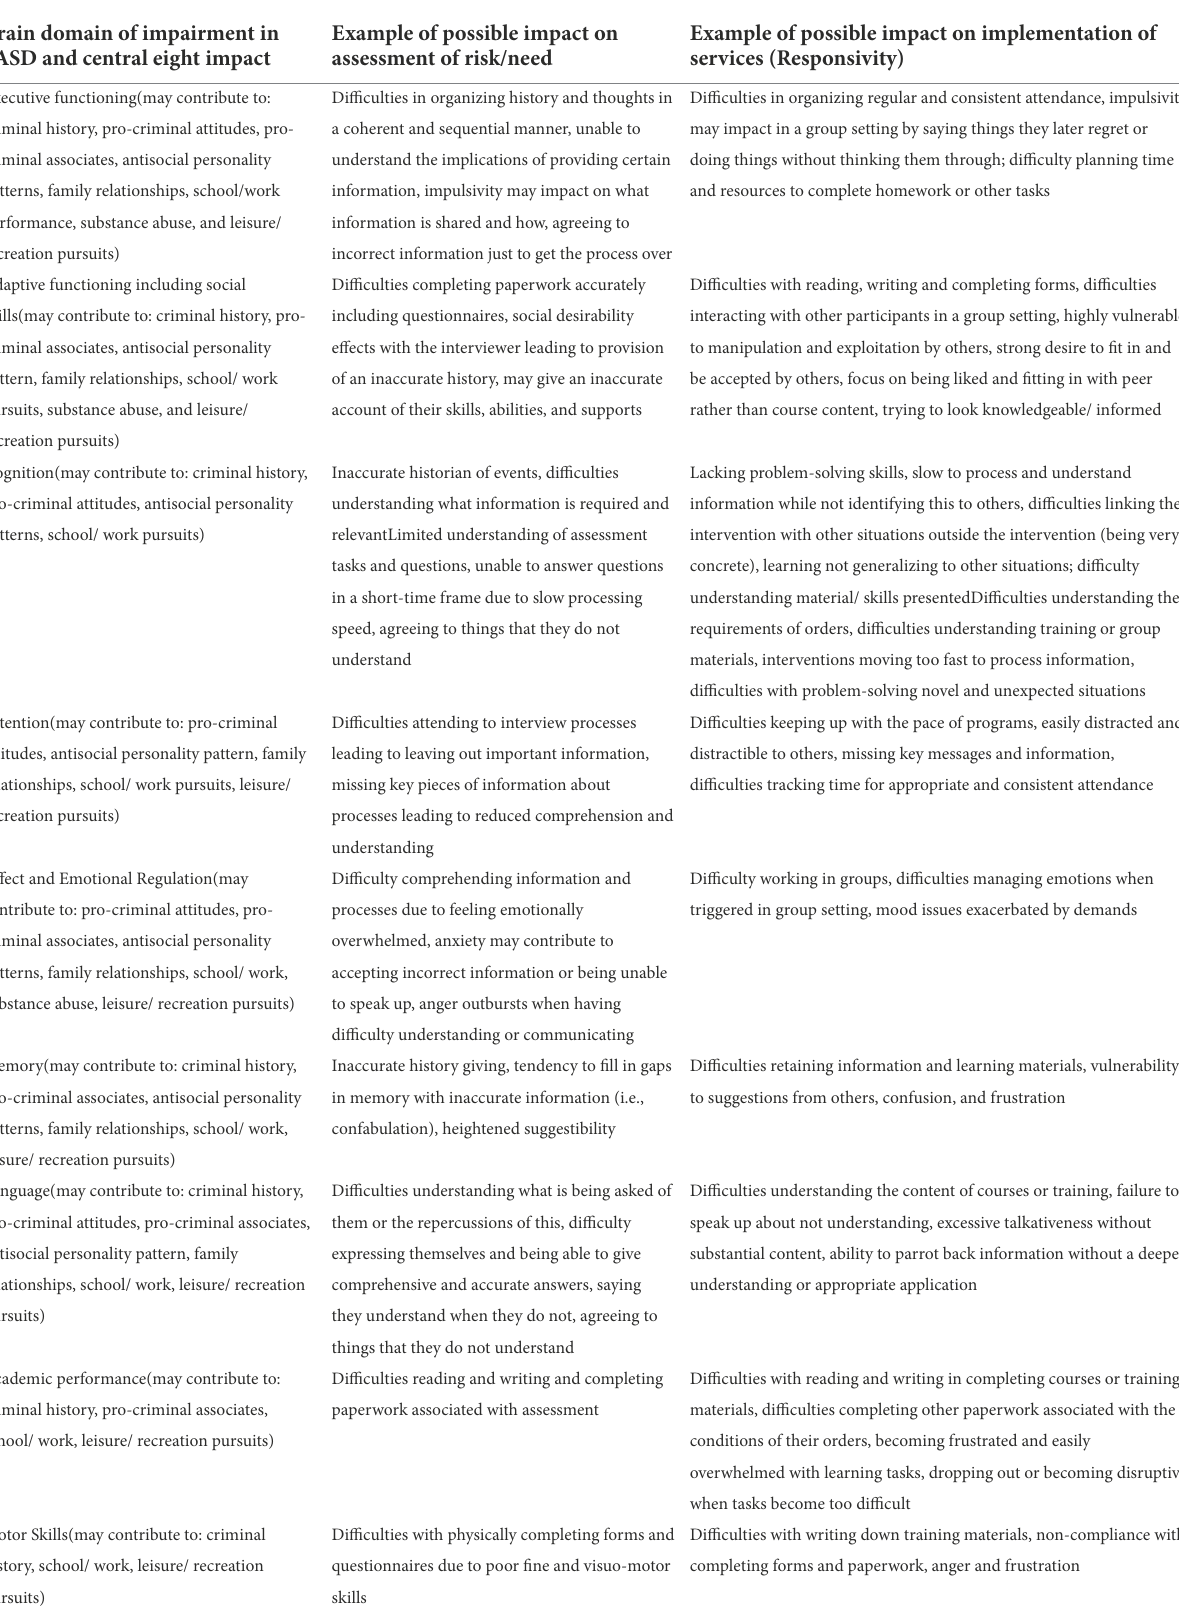
TABLE 3 Fetal alcohol spectrum disorder (FASD) features. Brain domain of impairment in FASD and central eight